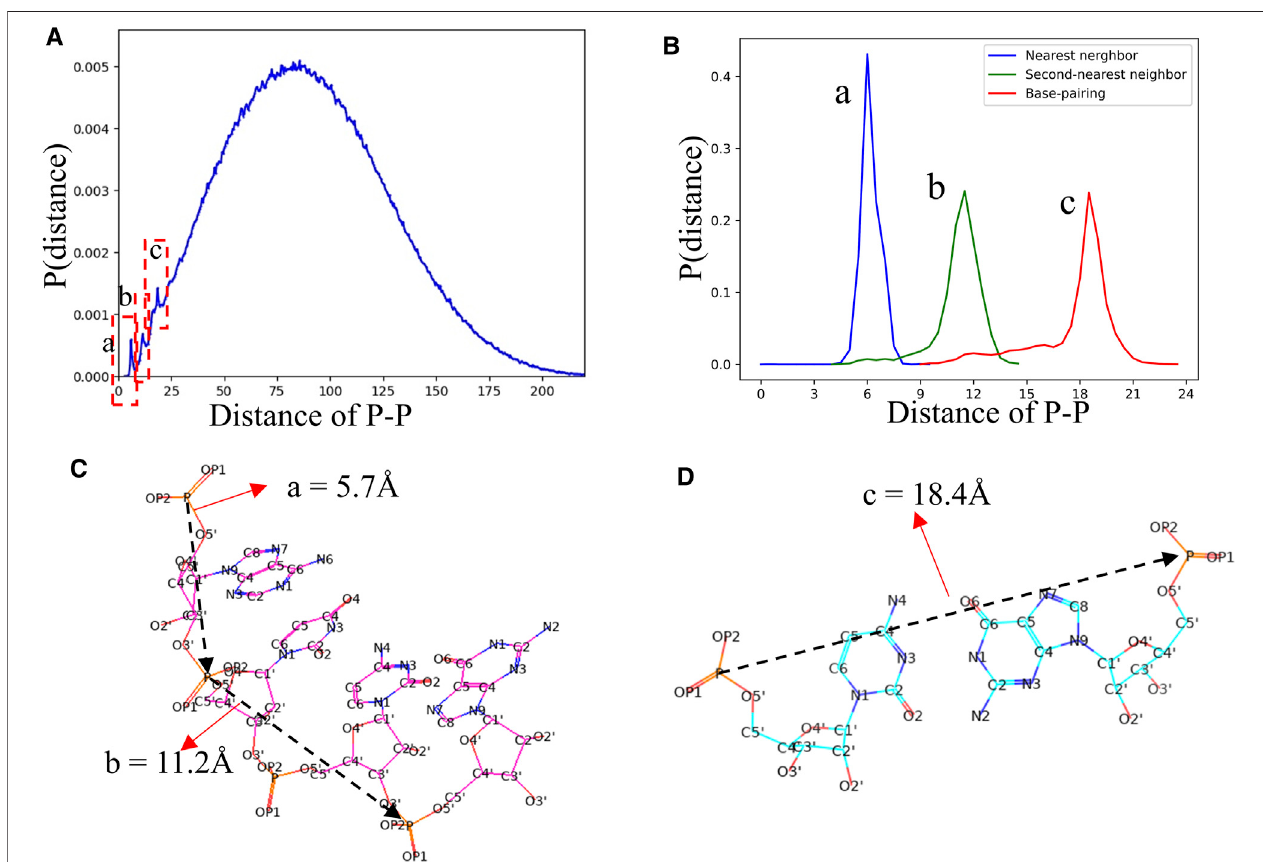
FIGURE 7 | (A) The distance distribution between P atoms in our dataset. Three signi fi cant peaks are marked by dashed boxes. (B) The distance distributions between two P atoms in the nearest neighbor nucleotides (a, blue line), second-nearest neighbor nucleotides (c, green line), and paired nucleotides (c, red line), respectively. (C, D) Schematic diagram of the distances between P atoms in the nearest neighbor nucleotide, second-nearest neighbor nucleotides, and paired nucleotides. The a, b, and c in (B – D) are corresponding to the three peaks in (A)